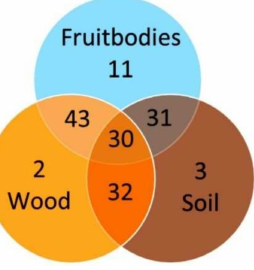
Figure 4. Venn diagram showing the diversity and overlap of invertebrate taxa in different substrates (sites as well as adults and larvae are combined).